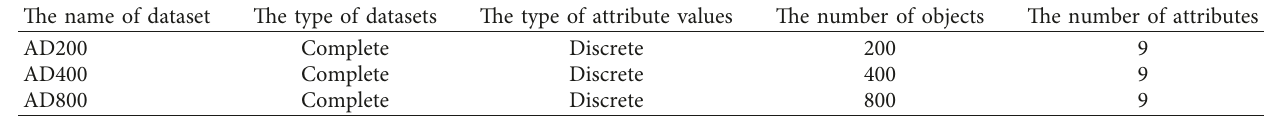
Table 8: The subsets of Adult dataset used in Experiments 1 and